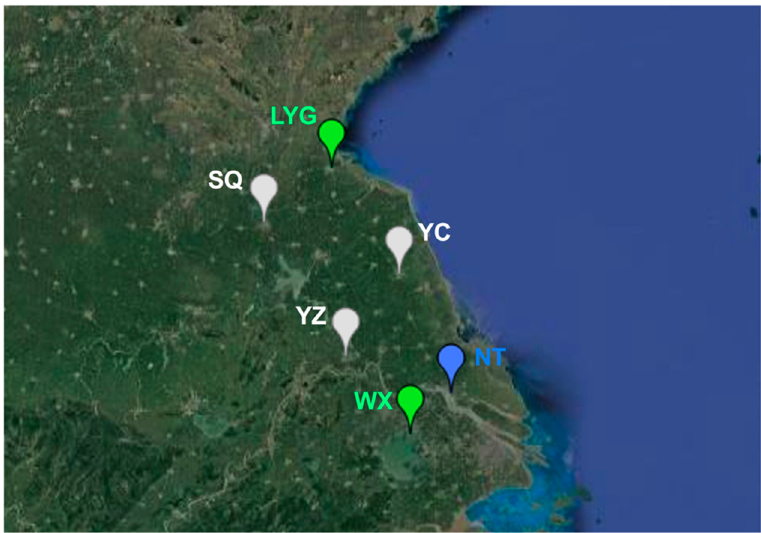
Figure 3. Population genetic structure of B. tabaci MED populations inferred by SAMOVA 2.0; LYG: Lianyungang; SQ: Suqian; YC: Yancheng; YZ: Yangzhou; NT: Nantong; WX: Wuxi. Table 2. Pairwise estimates of F ST between six populations of B. tabaci MED populations. Populations